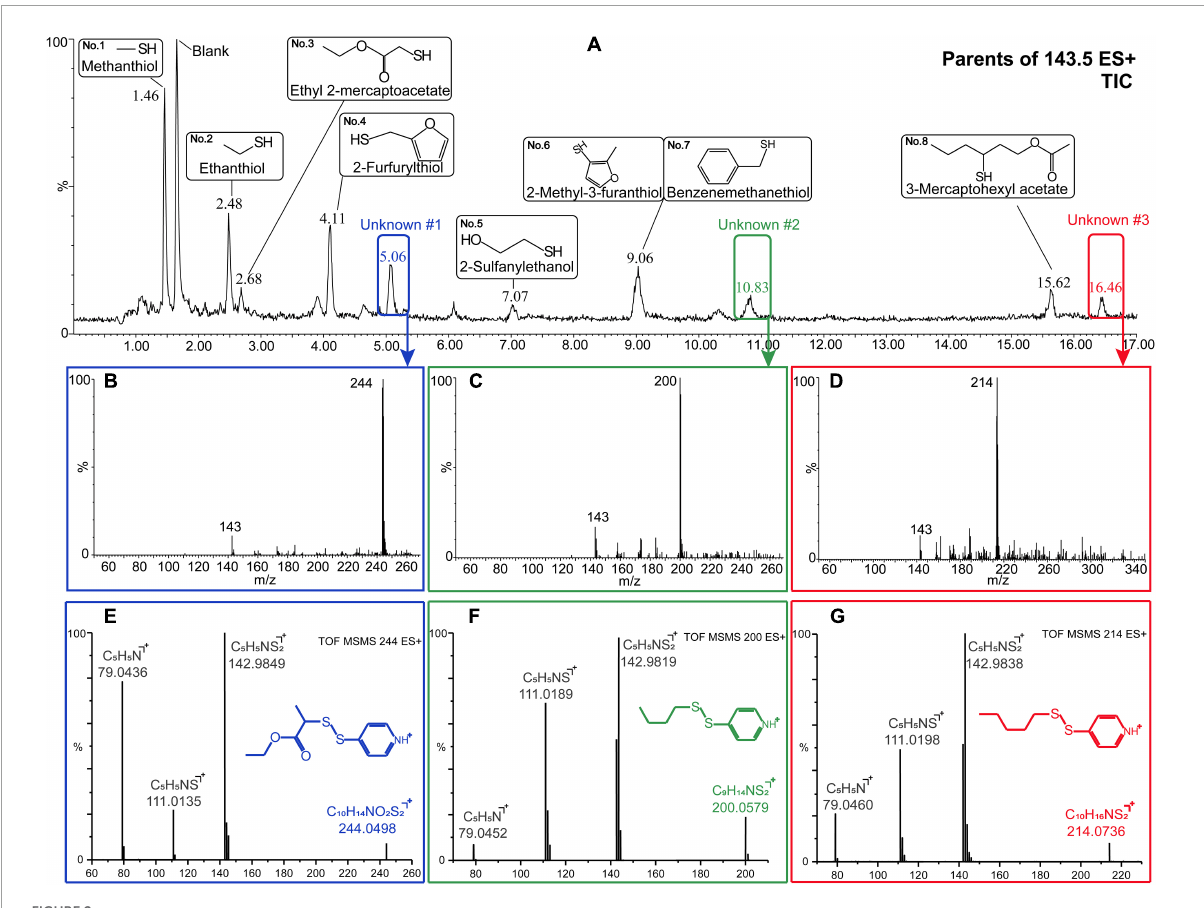
FIGURE2 Analysis of the derivatized Baijiu sample using precursor mode and ultraperformance liquid chromatography (UPLC)–mass spectrometry (MS/MS) screening for compounds releasing a disulfanylpyridin ion ( m/z X → 143.5) (A) . MS spectra of the three unknown peaks by UPLC–MS/MS (B–D) . MS peaks observed at 5.06 (unknown #1), 10.83 (unknown #2), and 16.46 min (unknown #3) using ultraperformance liquid chromatography quadrupole-time-of-flight mass spectrometry (UPLC–Q-TOF–MS) and their corresponding elemental composition (E–G)